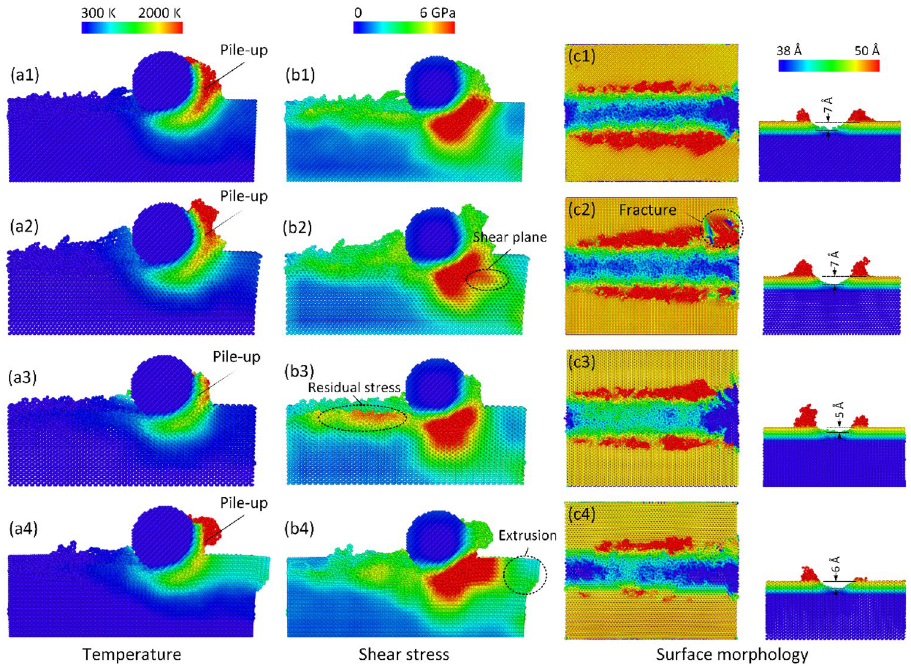
Figure 5. Temperature, shear stress distributions, and surface morphology of different orientations at 300 K, 100 m/s, and 10 Å depth: ( a1 – c1 ) (100)[100], ( a2 – c2 ) (100)[110], ( a3 – c3 ) (110)[100], and ( a4 – c4 )